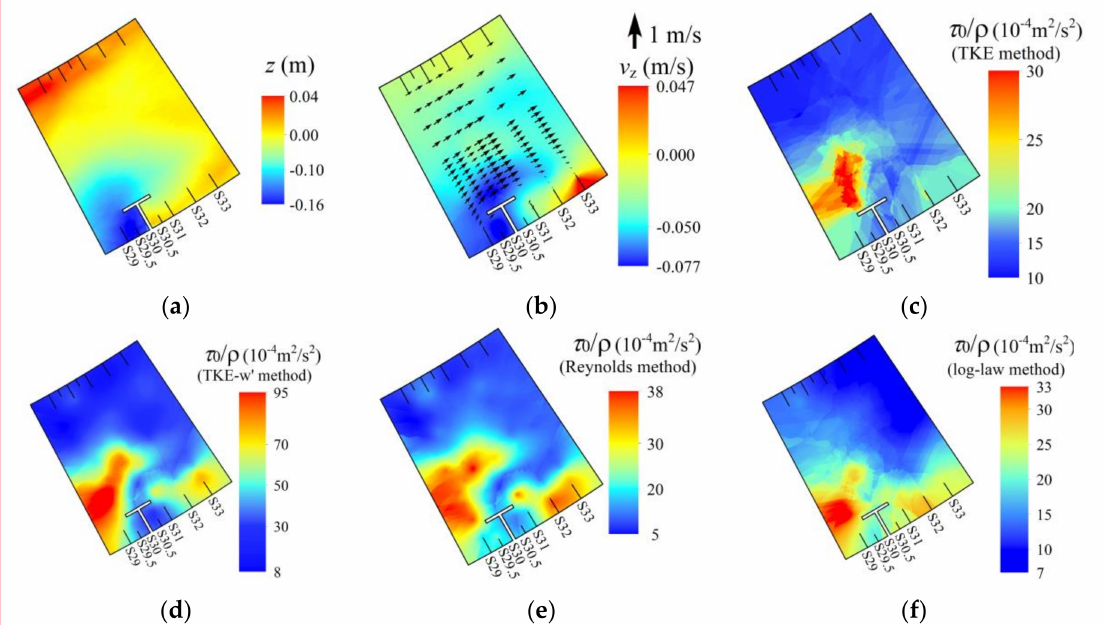
Figure 6. ( a ) Bed topography around the groyne; ( b ) depth-averaged velocity vectors (UV components, “1 m / s” corresponds to the size of the arrow on the left) and depth-averaged vertical velocity filled contours (W component, positive values represent upward velocity); ( c ) bed shear stress (TKE method); ( d ) bed shear stress (TKE-w (cid:48) method); ( e ) bed shear stress (Reynolds method); ( f ) bed shear stress (log-law